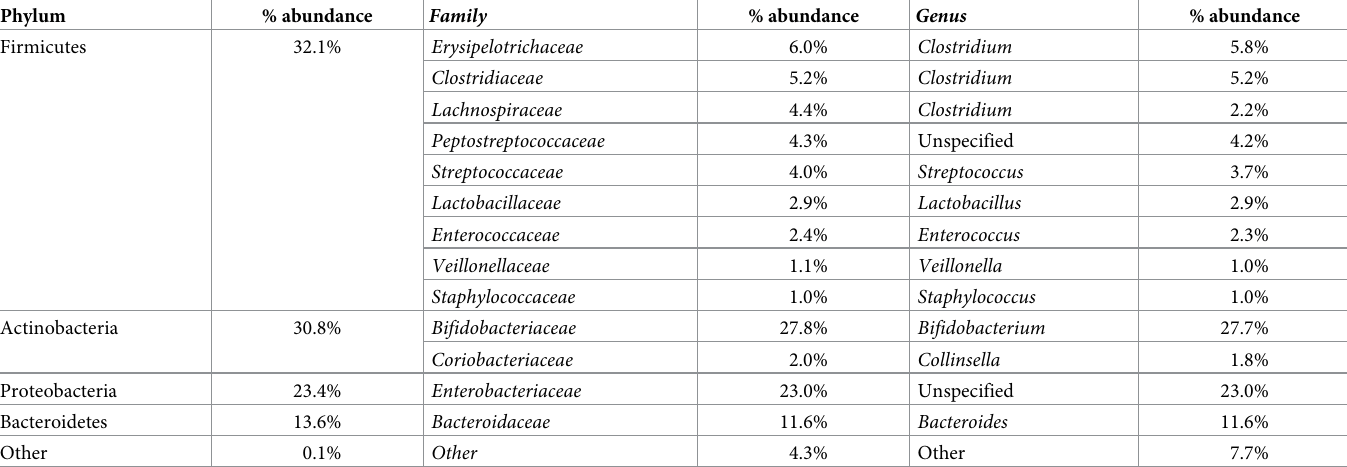
Table 2. Average infant gut microbiota composition at the phylum, family, and genus taxa. Phylum % abundance